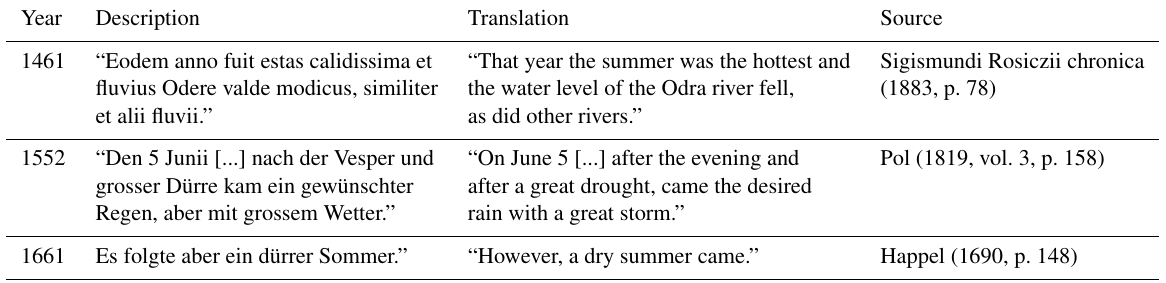
Table 5. Descriptions of moderate droughts in 15th–17th-century